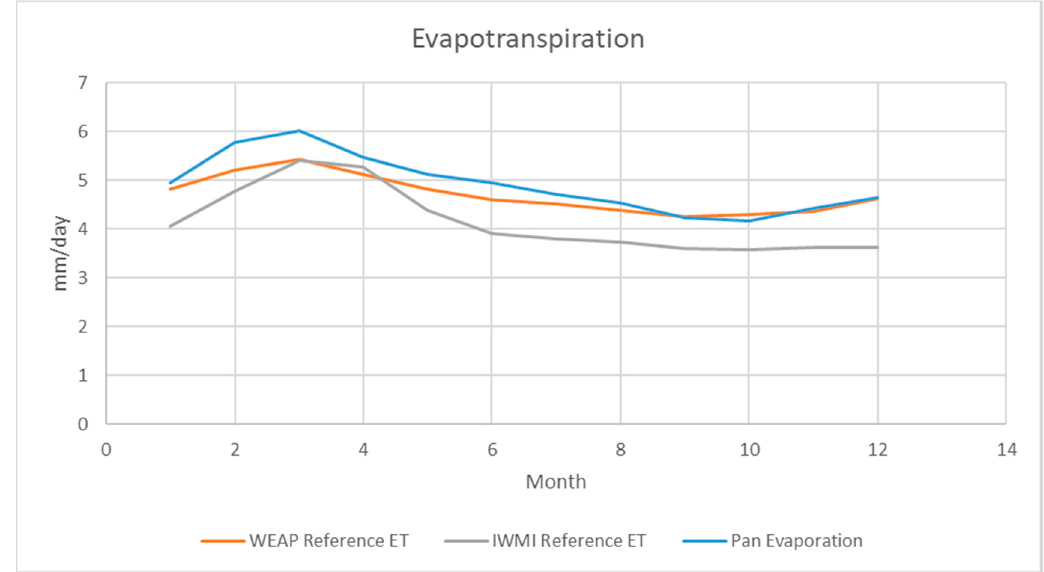
Figure 6. WEAP reference Evapotranspiration (ET) comparison with other estimates.